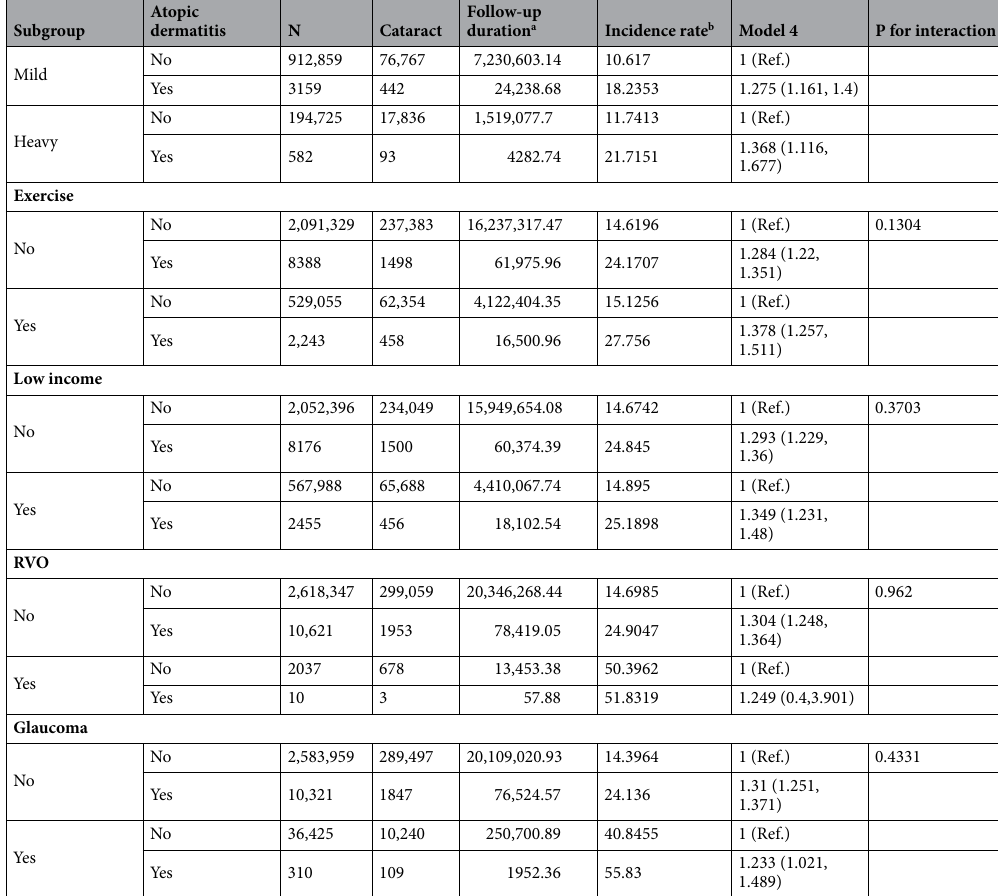
Table 3. Association between cataract and atopic dermatitis subjects according to subgroup. Model 4 is adjusted for age, sex, smoking, drinking, regular exercise, low income, DM, hypertension, dyslipidemia, CKD, and BMI. BMI, body mass index; DM, diabetes mellitus; CKD, chronic kidney disease; RVO, retinal vascular occlusion. a Follow-up duration is in person-years. b Incidence rate is presented as 1000